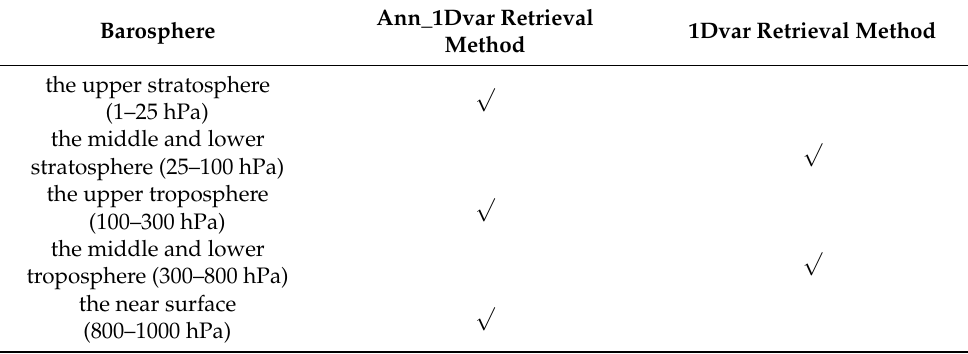
Table 3. A set of ozone profile retrieval schemes suitable for FY-3D/HIRAS,